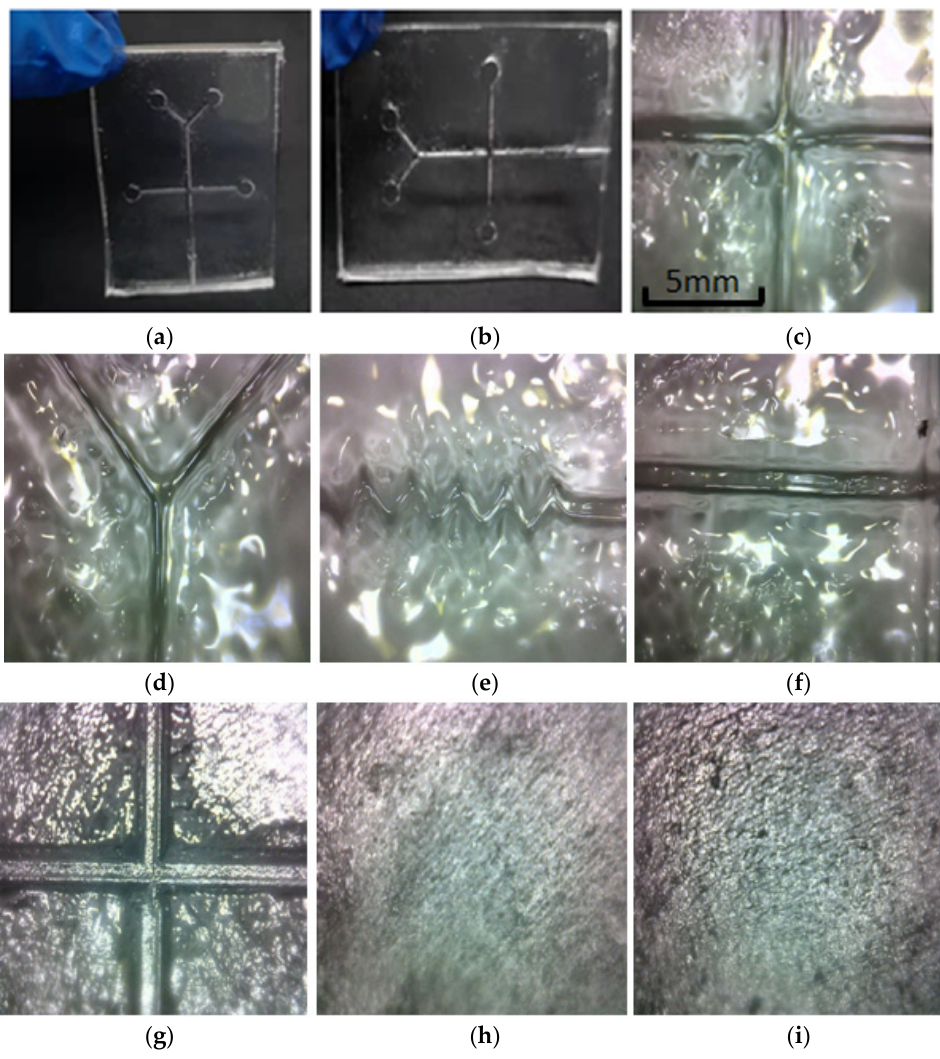
Figure 8. Molding state after drying at 75 °C. Figures ( a – f ) show that the surface forming effect of the runner is better without too obvious defects; ( g – i ) shows that the substrate mold does not appear obvious cracks during the drying process.